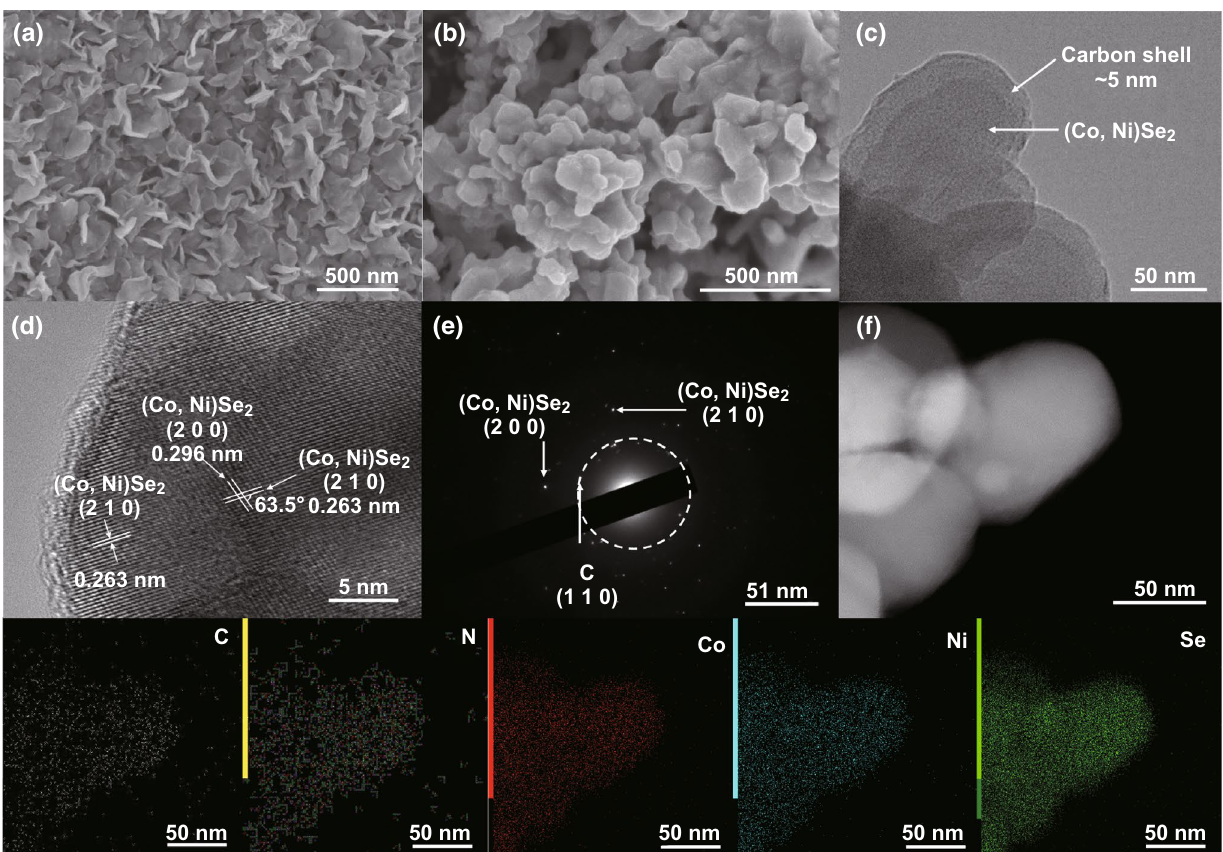
Fig. 2 a , b FESEM images of EG/CoNi–LDH and EG/(Co, Ni)Se 2 –NC. c, d TEM and HRTEM images of EG/(Co, Ni)Se 2 –NC. e SAED pat- tern of EG/(Co, Ni)Se 2 –NC. f EDX and elemental mapping of analyzed elements: C, N, Co, Ni, and